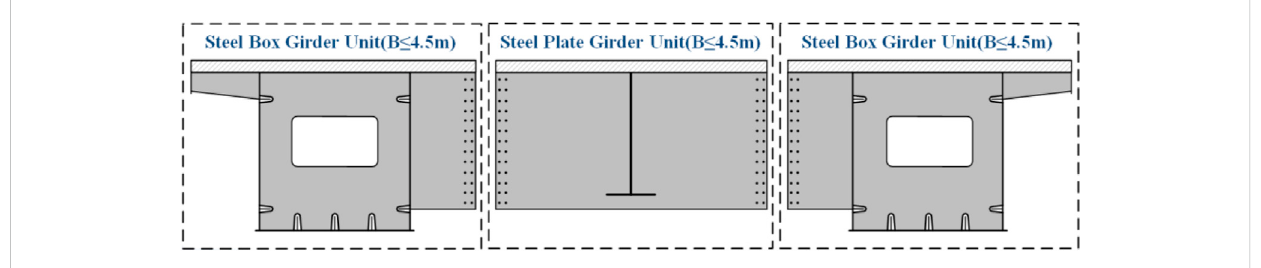
Standardized Manufacturing Unit of Steel box-Steel plate Composite Beam.